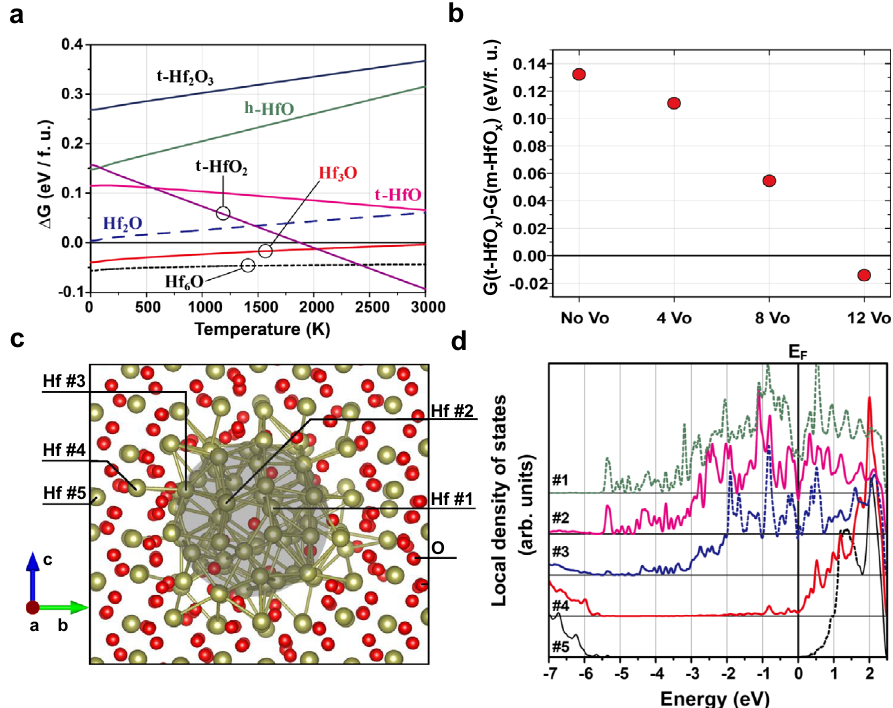
Fig. 4 Ab initio calculations of the HfO x system. a Relative free energy per HfO x formula unit of t-HfO 2 , t-HfO, t-Hf 2 O 3 , h-HfO, h-Hf 2 O, h-Hf 3 O, and h-Hf 6 O against the decomposed h.c.p Hf and m-HfO 2 . b The Gibbs free energy of t-HfO x with reference to m-HfO x at 300 K, evaluated at several V O concentrations by introducing various amounts of V into a Hf 32 O 64 supercell. c Atomistic structure of our Hf 6 O-in-m-HfO 2 CF model, where the Hf 6 O O metal core is shaded. d The local density of states on several marked Hf atoms in this model with the Fermi level aligned to